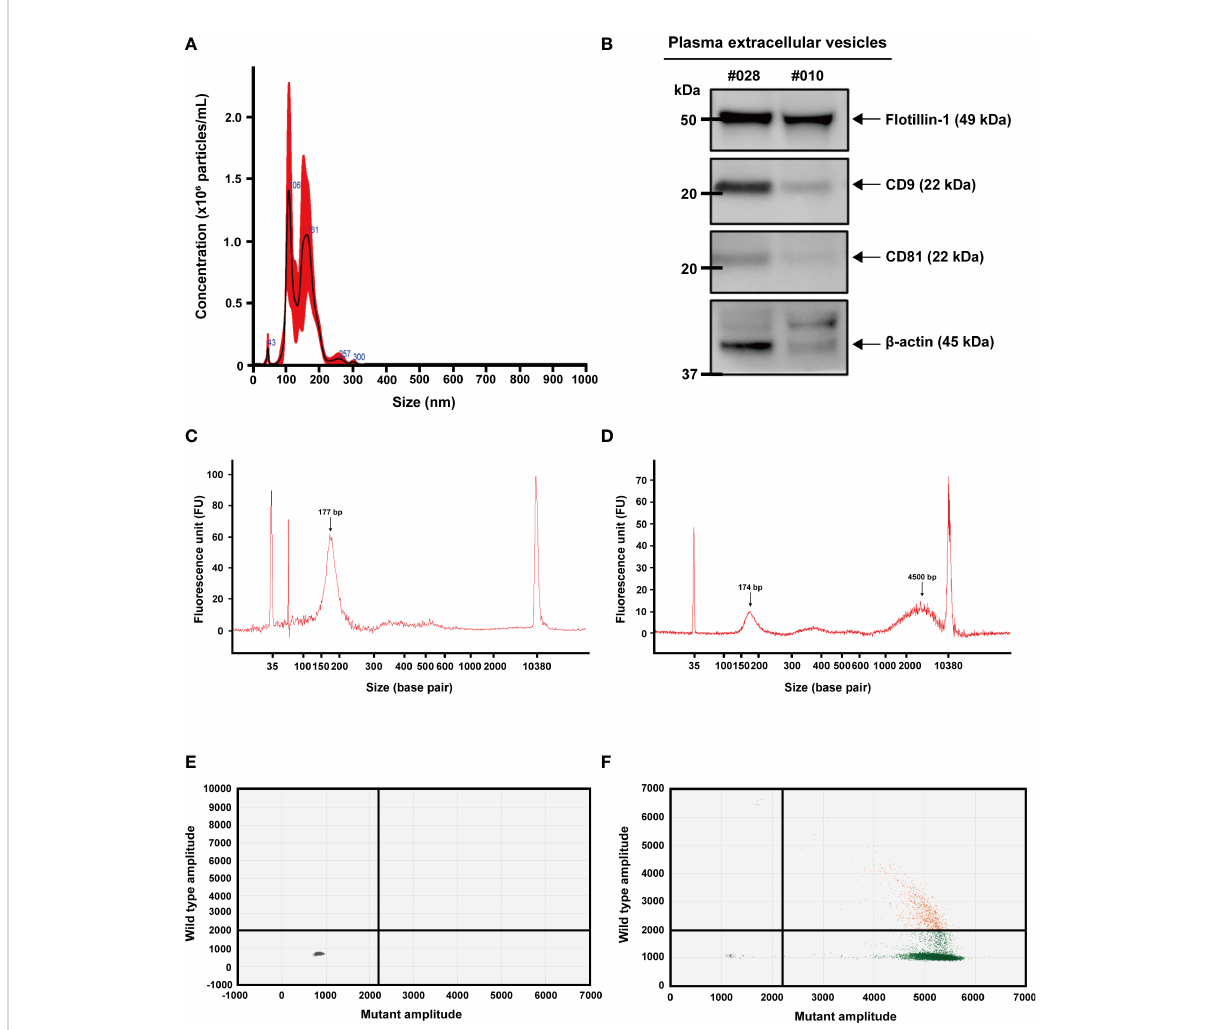
FIGURE 1 Characterization of extracellular vesicles, extracellular vesicle DNA, and cell-free DNA. (A) Nanoparticle tracking analysis (NTA) for counting particle number and size distribution of extracellular vesicles isolated from plasma using ultracentrifugation. (B) Detection of extracellular vesicle proteins by western blot analysis. Common markers (CD-9, CD-81, and Flotilin-1) were detected in extracellular vesicles isolated from plasma. (C) Detection of cell-free DNA (arrow) by Agilent 2100 Bioanalyzer. (D) Detection of extracellular vesicle DNA (right arrow) and a sign of minimally remaining cell-free DNA (left arrow). (E, F) 2D intensity scatter plot of KRAS wild-type and KRAS G13D mutant droplets in droplet digital PCR. Plots in each region represent droplets containing wild-type (green; lower right), mutant (blue; upper left), wild-type and mutant (orange; upper right), and no template (gray; lower